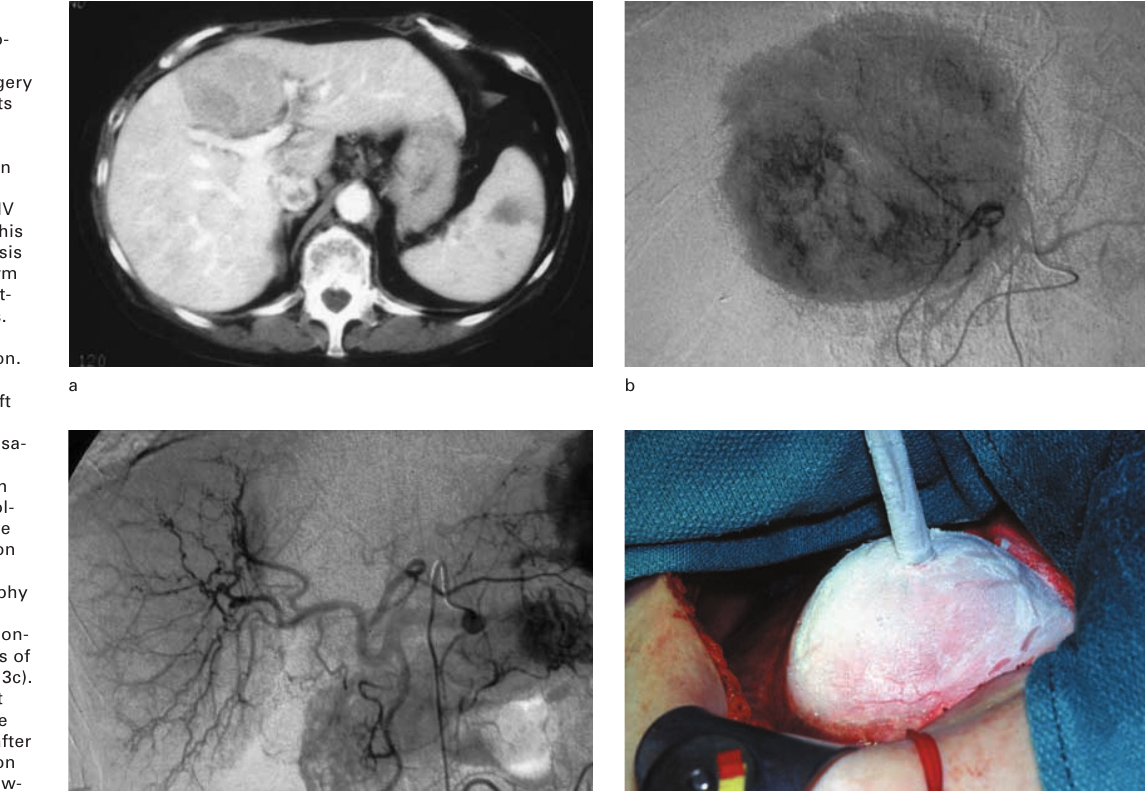
Protocol of chemo- embolisation fol- lowed by cryosurgery in cirrhotic patients with unresectable HCC. CT-scan in a 77-year-old woman showing a large mass in segment IV of liver (fig. 3a). This patient had cirrhosis related to long-term methotrexate treat- ment for